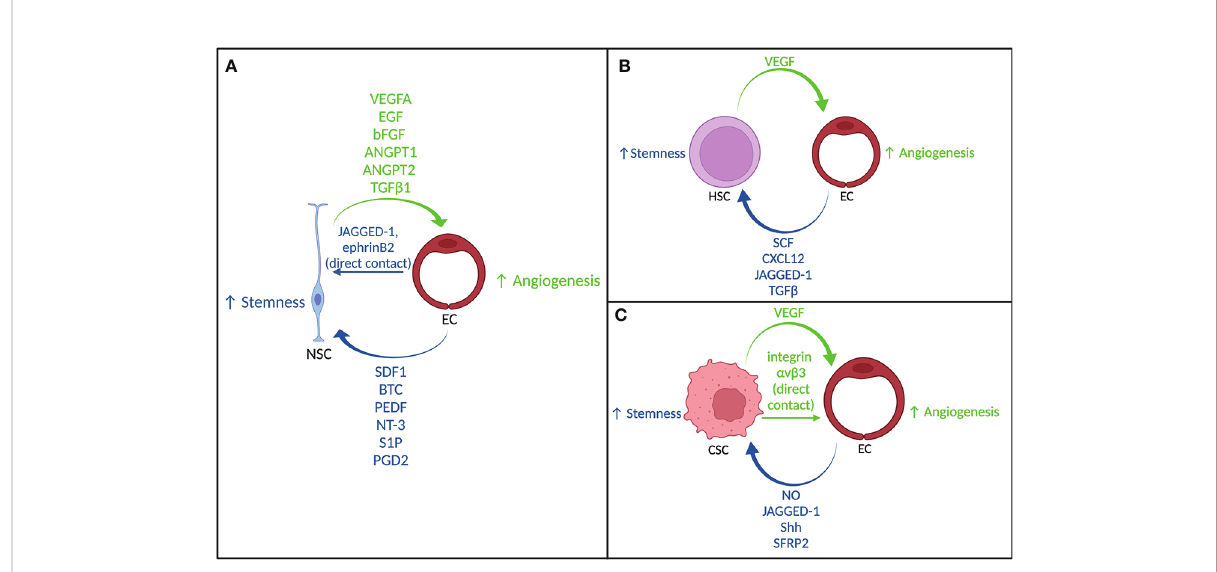
FIGURE 1 Crosstalk between stem cells and endothelial cells. (A) Signaling between neural stem cells and endothelial cells. (B) Signaling between hematopoietic stem cells and endothelial cells. (C) Signaling between cancer stem cells and endothelial